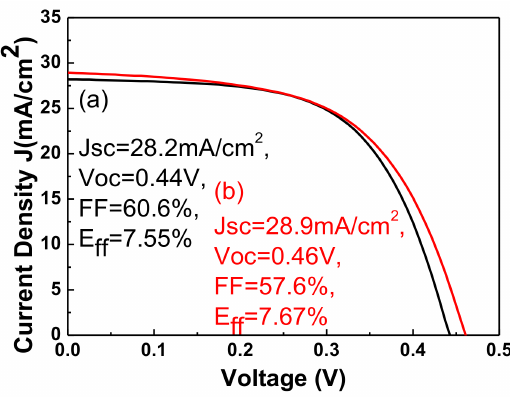
Figure 7. The current-voltage (CV) curves of CIGS solar cells with the window layer of ( a ) sputtered ZnO:Al, and ( b ) electrodeposited ZnO:Cl